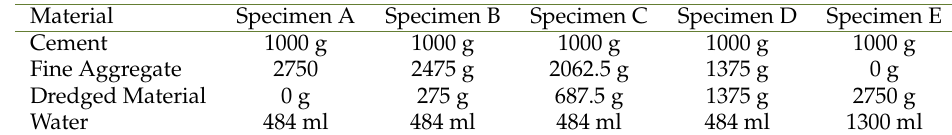
Table 1. Concrete Mixture: Different Dredged Material to Sand Ratio